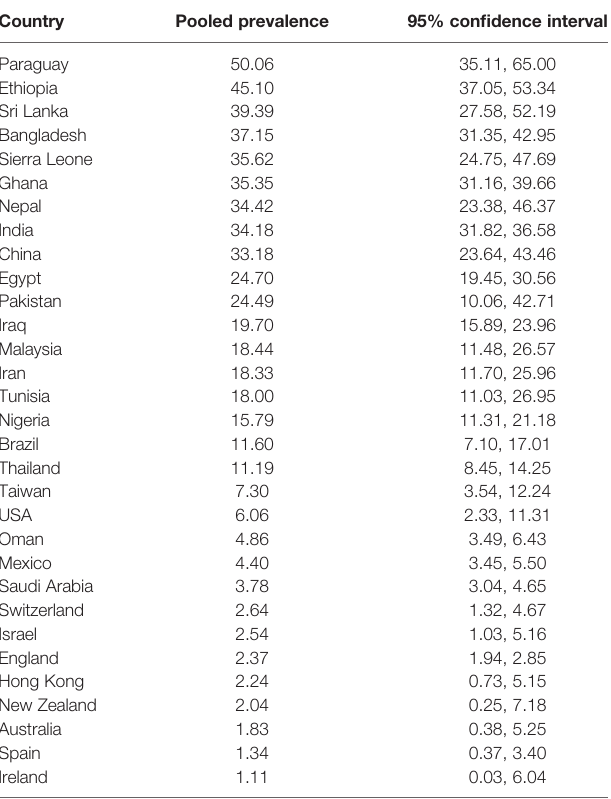
TABLE 2 | The pooled prevalence of fungal keratitis among patients clinically suspected of microbial keratitis in various countries (1990 up to May 27, 2020). Country Pooled prevalence 95% con fi dence interval